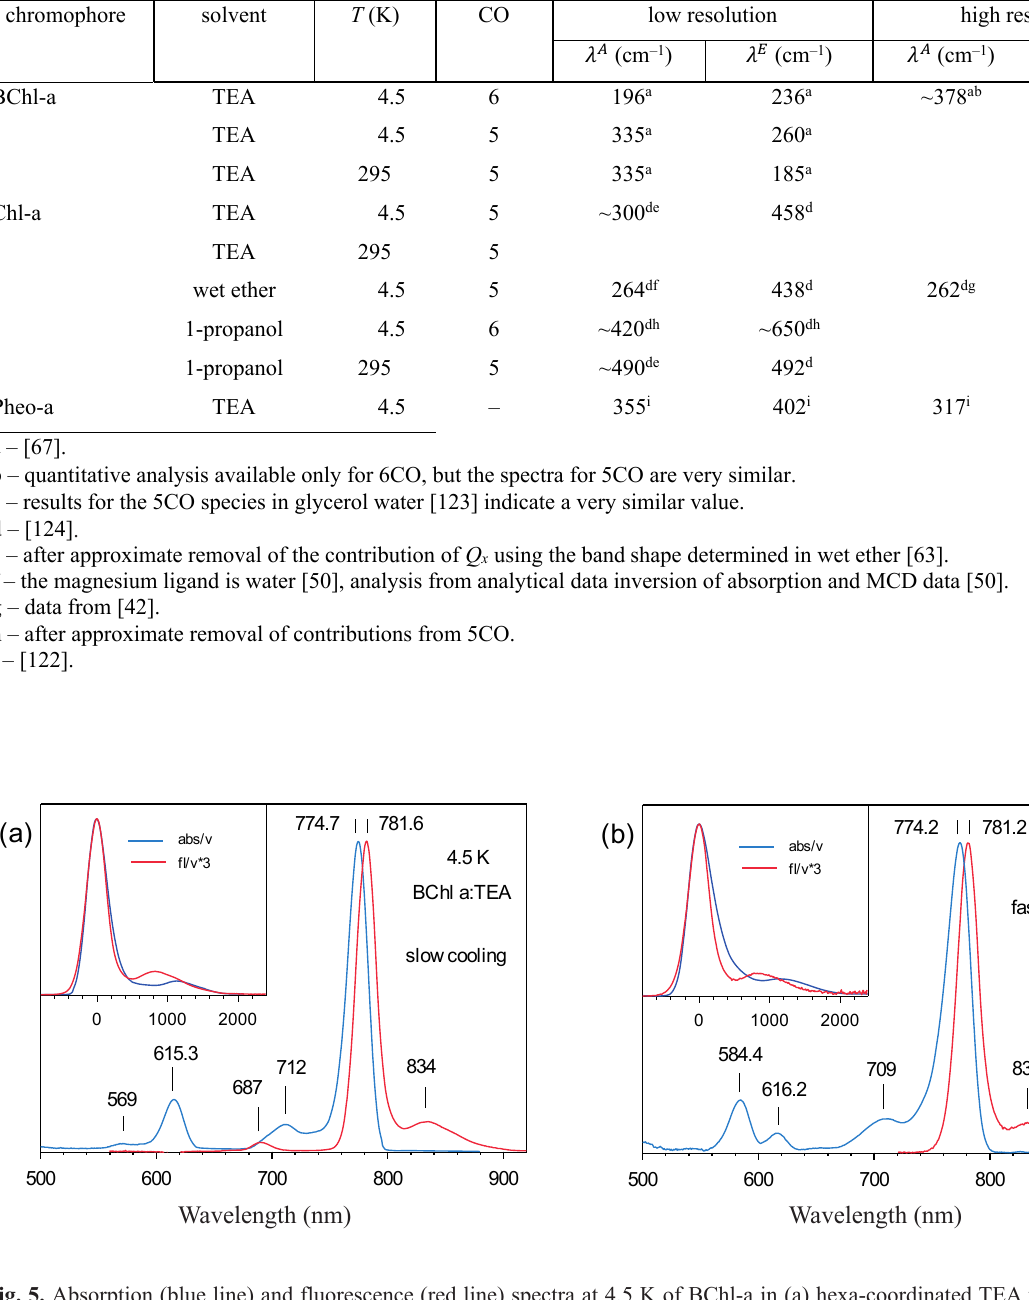
Fig. 5. Absorption (blue line) and fluorescence (red line) spectra at 4.5 K of BChl-a in (a) hexa-coordinated TEA following slow cooling and (b) mostly penta-coordinated TEA following rapid cooling. The fluorescence spectra were excited at around 405 nm. The vertical lines label band positions in nanometers. The insets show the overlap of the absorption and emission spectra in transition dipole moment representation as a function of the frequency differences 𝜈 − 𝜈 wavenumbers. Reprinted with permission from [67]. Copyright 2011 AIP Publishing.